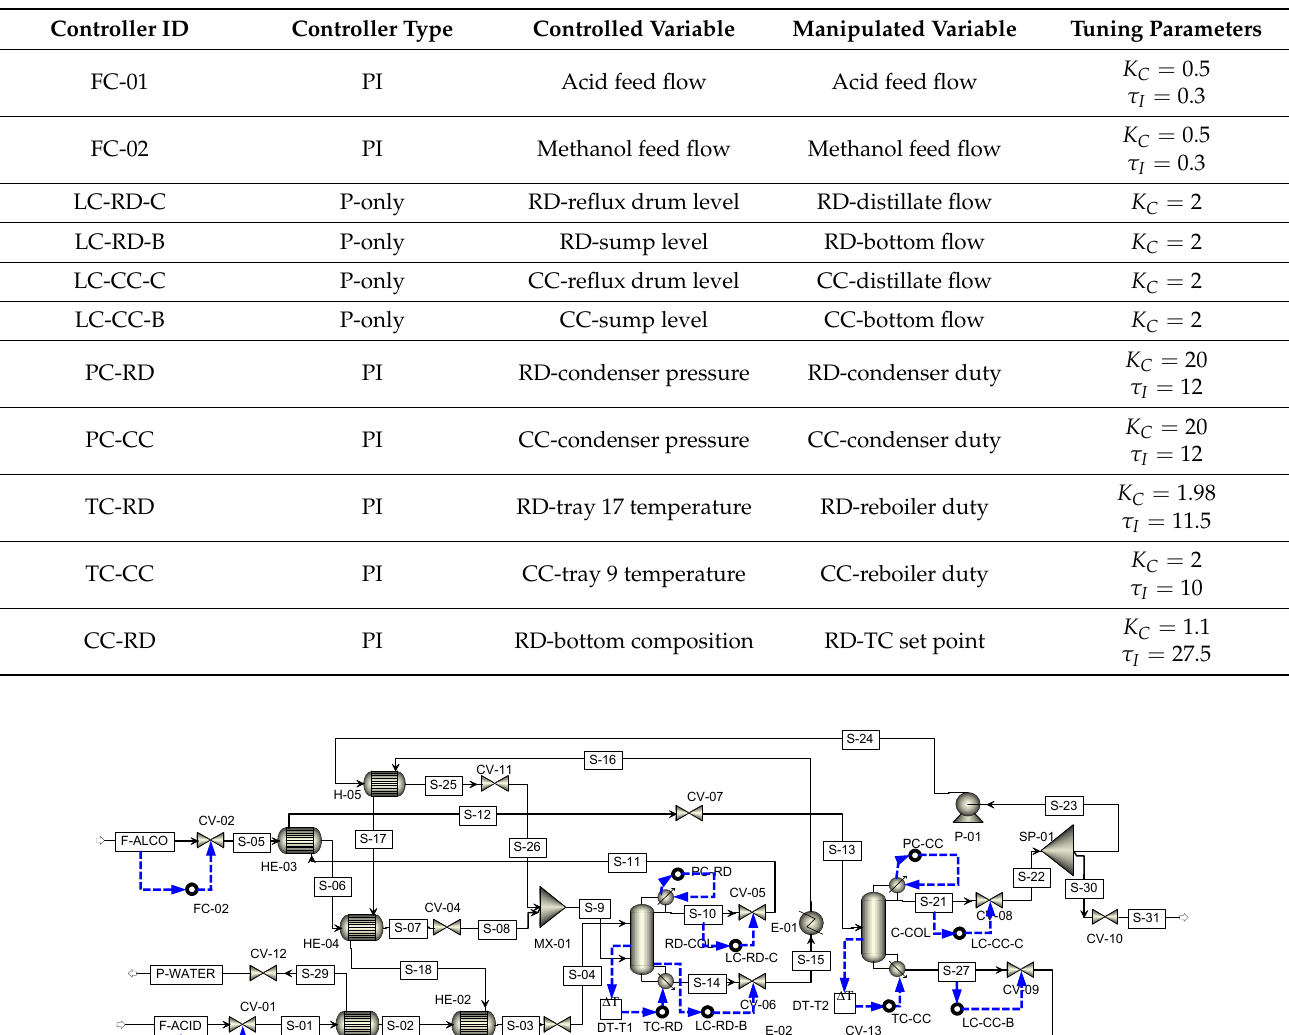
Table 6. Controller details and tuning parameters.